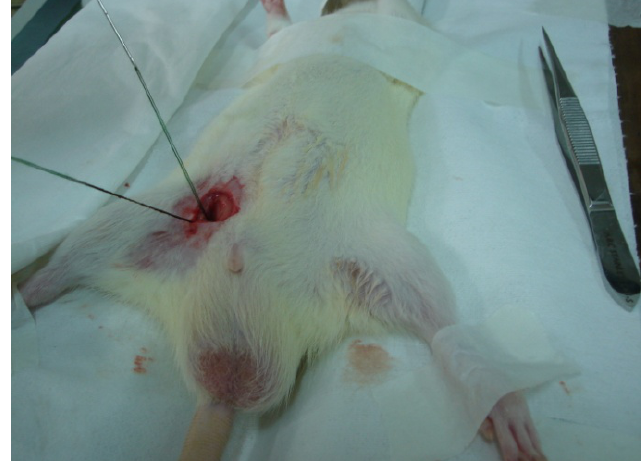
FIGURE 2 – Femoral artery occlusion procedure.